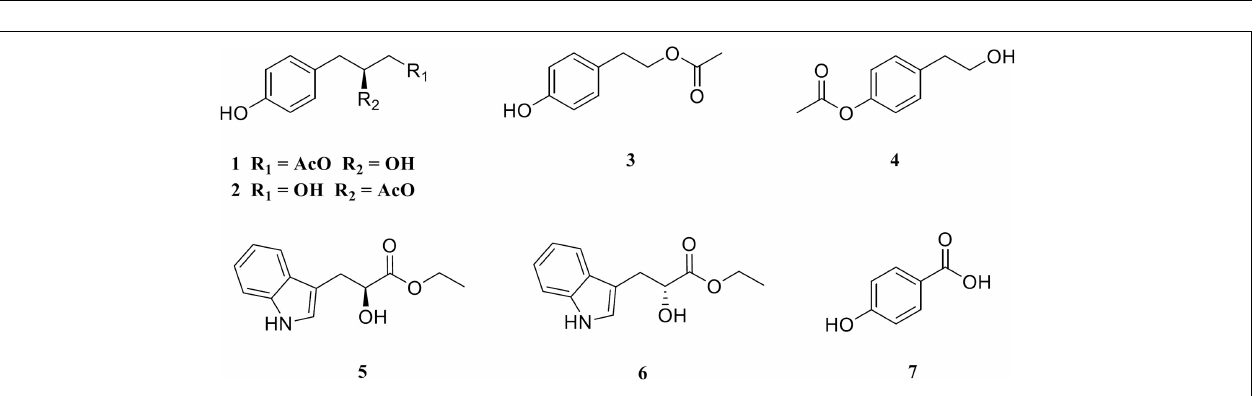
FIGURE 5 | Structures of the compounds from Amycolatopsis aidingensis YIM96748 T .